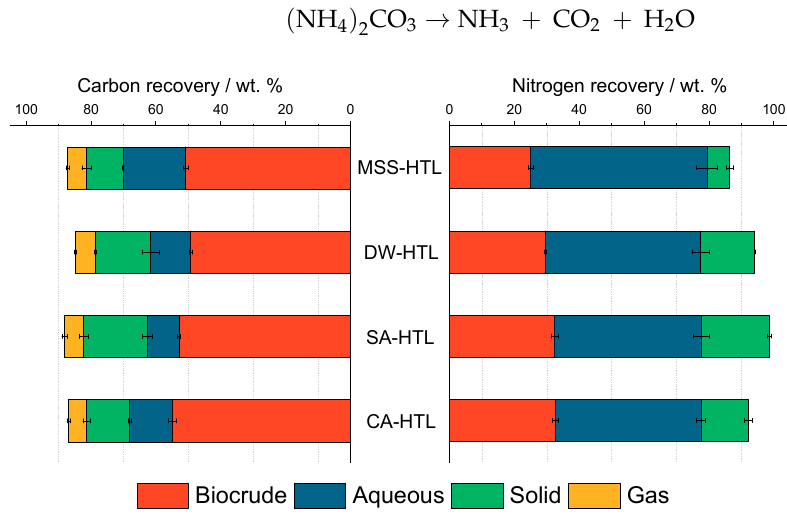
Figure 5. Carbon and nitrogen recovery in the different product phases of HTL.